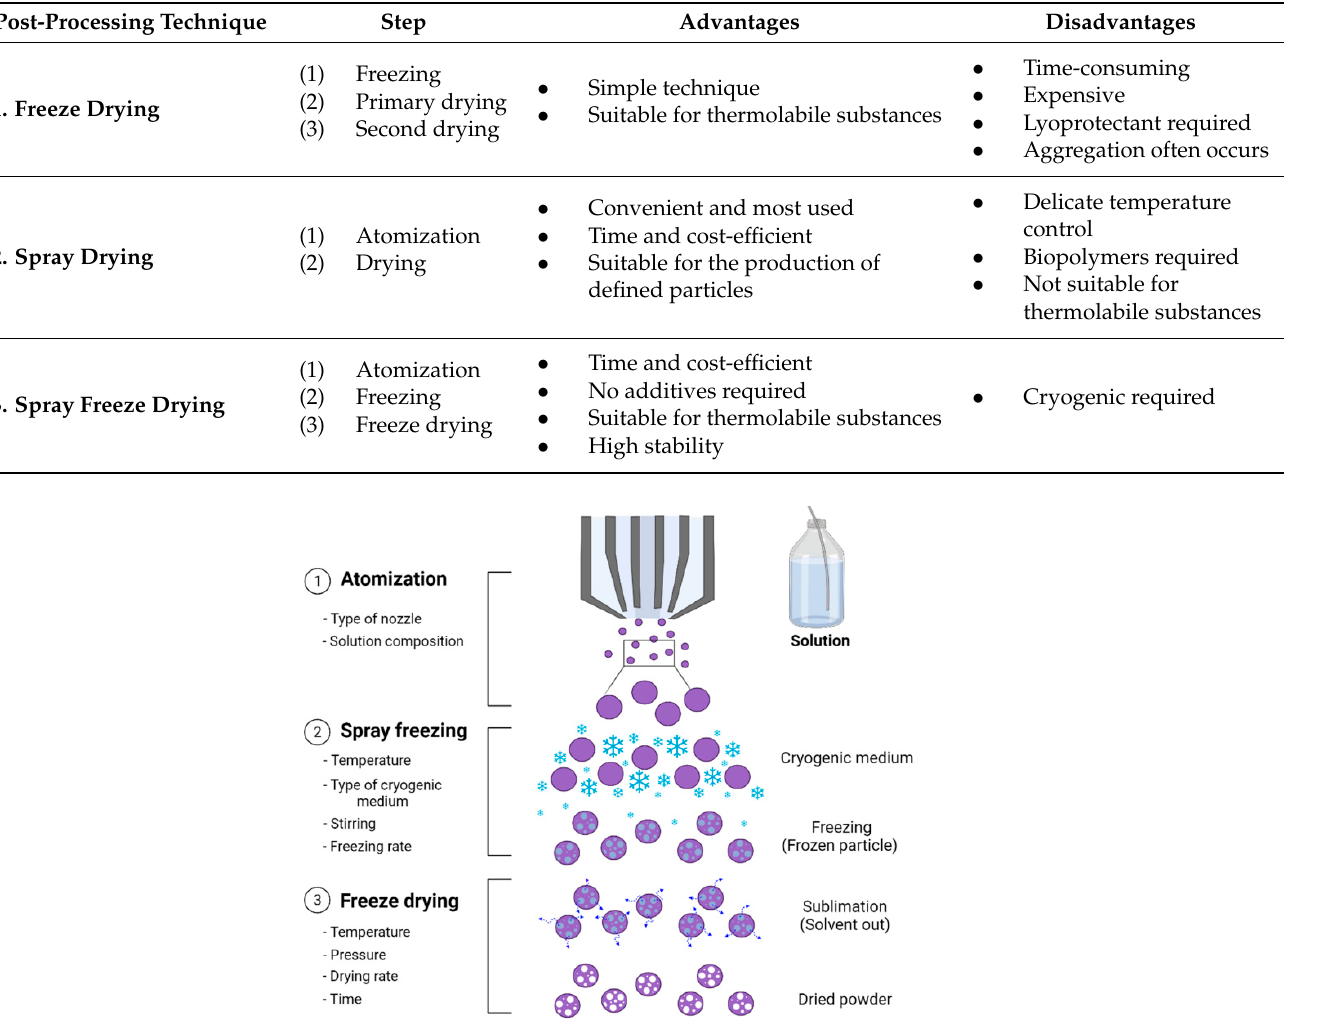
Table 3. Advantages and disadvantages of three post-processing techniques.